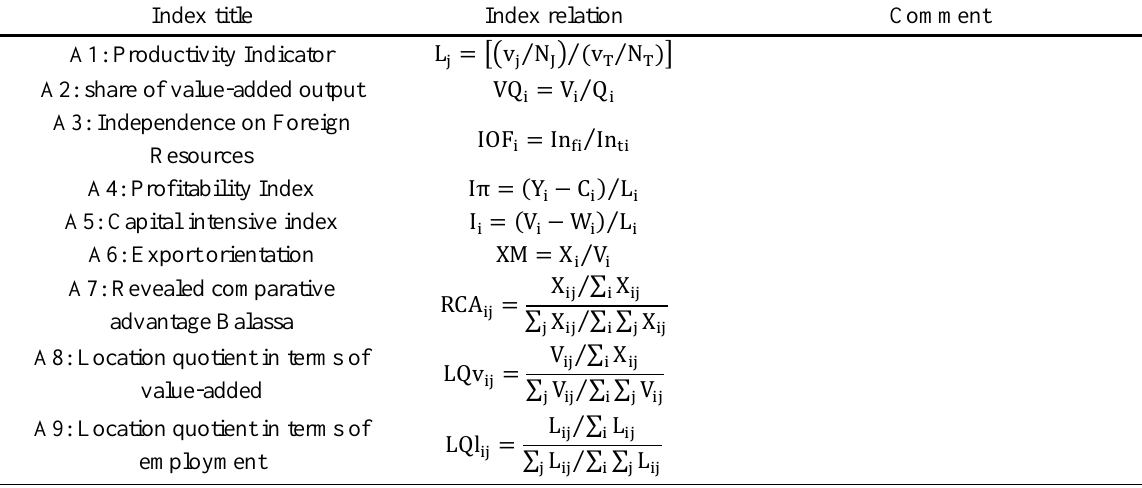
Table 1. Investment priority